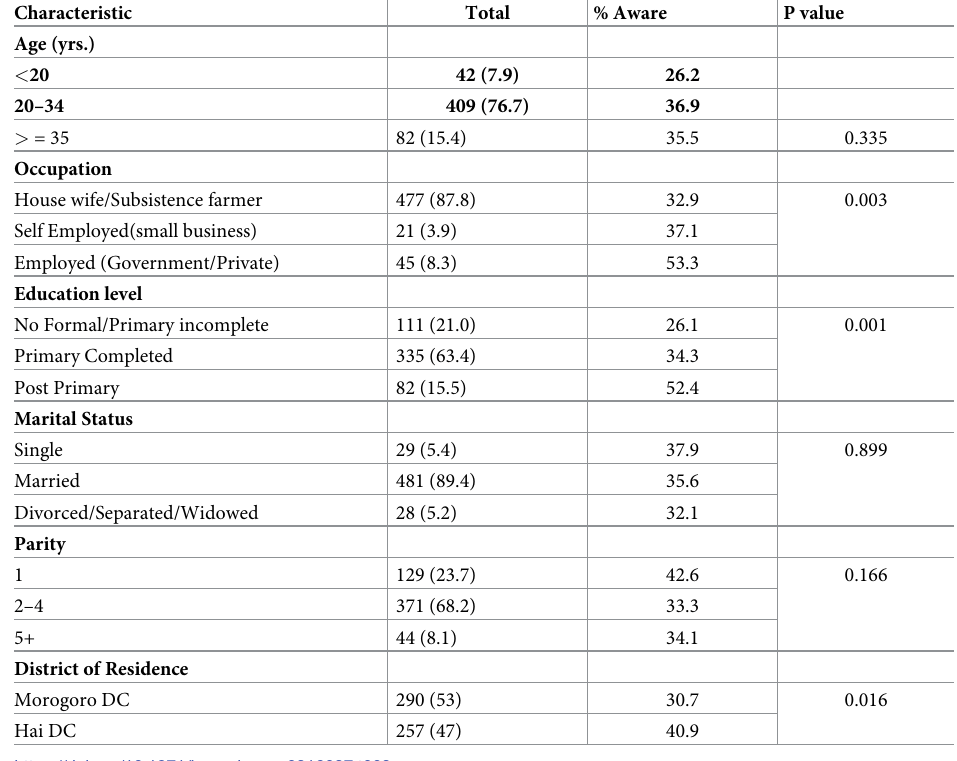
Table 2. Chi square test results showing awareness of the right to access maternal health services by socio-demo- graphic characteristics. Characteristic